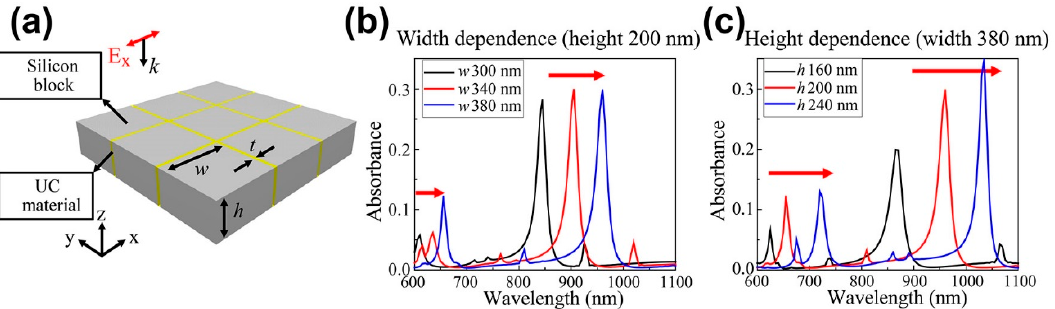
Figure 1. ( a ) Proposed cross-patterned upconversion (UC) material slot waveguide structure on silicon thin layer, where w and h are the width and height of each silicon layer block, respectively, and t is the slot thickness; simulated Er 3+ /Yb 3+ doped NaYF 4 UC material slot absorbance spectra for different ( b ) widths and ( c ) heights.